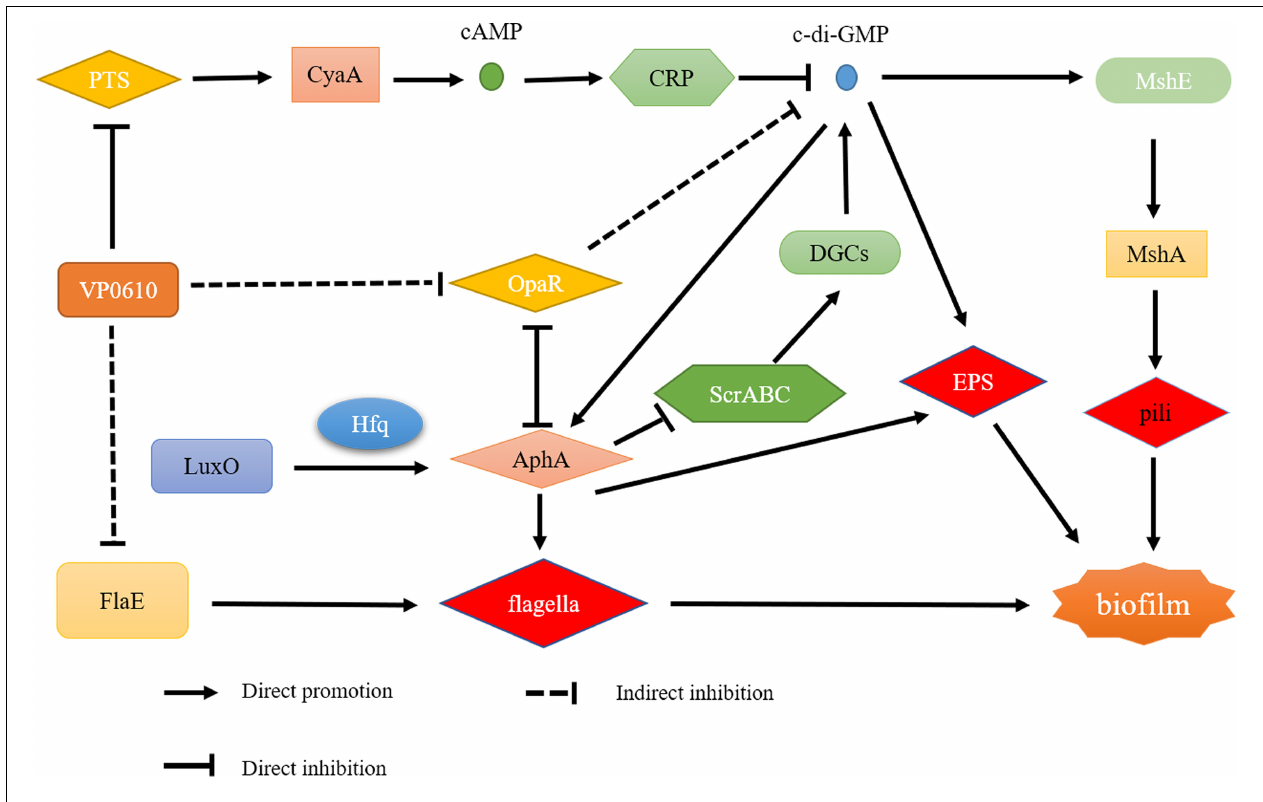
FIGURE 8 | Regulatory network of